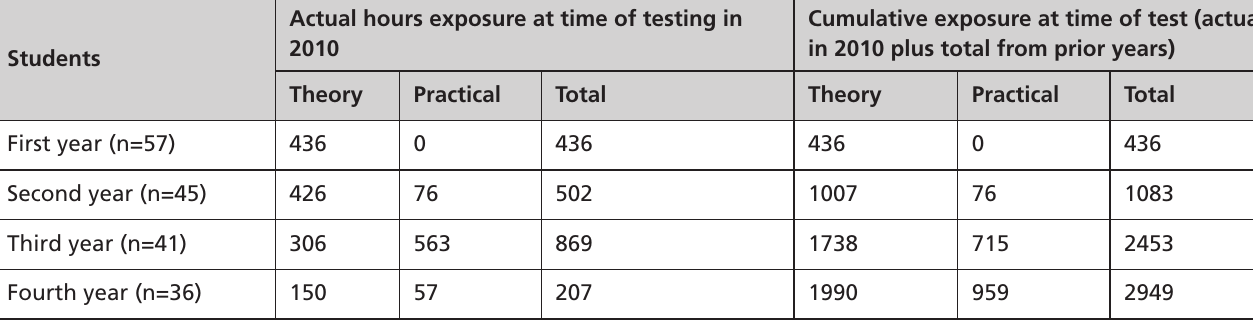
Actual hours exposure at time of testing in